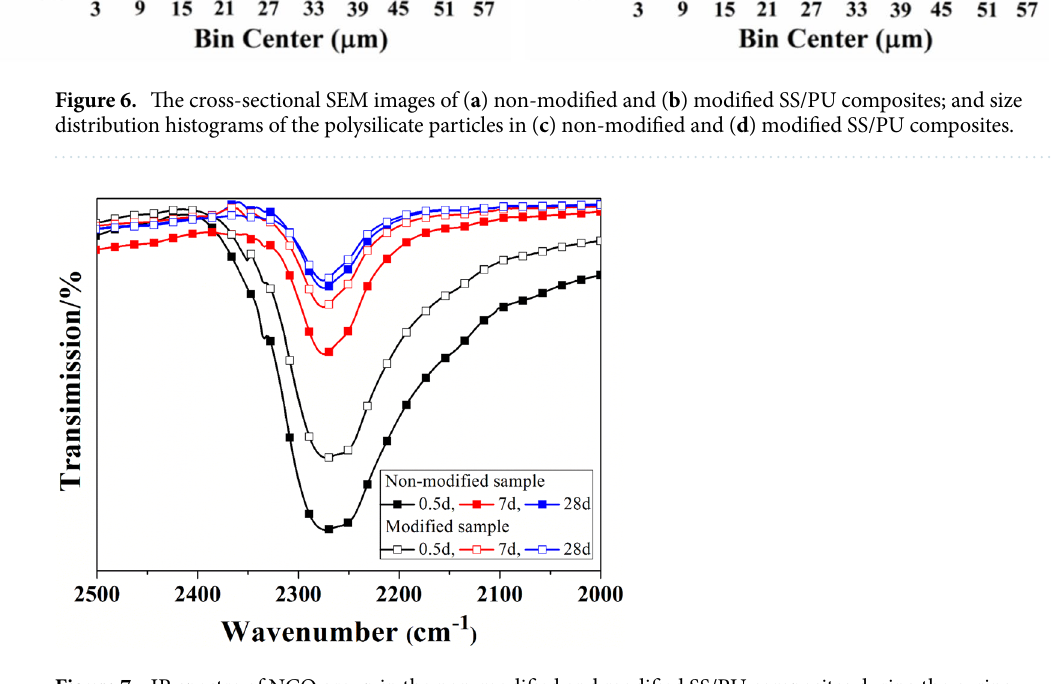
Figure 7. IR spectra of NCO group in the non-modified and modified SS/PU composites during the curing